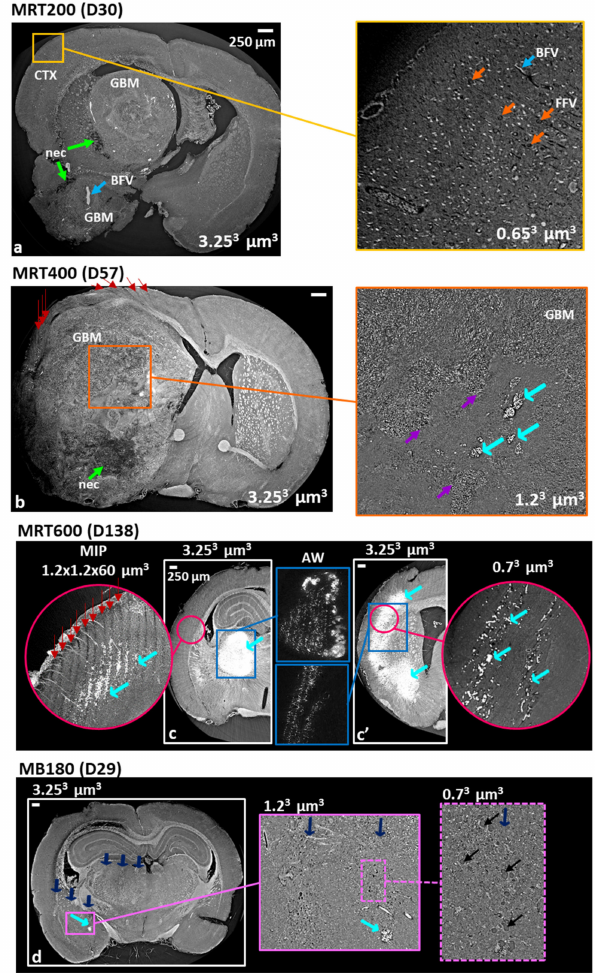
Figure 5. Multi-scale XPCI-CT coronal images of MRT and MB180-treated tumor-bearing brains. The MRT200 sample ( a ) shows great discrimination between healthy and tumor tissue distinguishing necrosis (nec, green arrows) among the GBM structures. A cortex zoom was realized with a 0.7 3 µ m 3 voxel size setup revealing uniform cell content and no MRT path track. Orange and light-blue arrows indicate formalin (ffv) and blood-filled (bfv) vessel. ( b ) Reports an MRT400-treated sample displaying MRT paths induced tissue ablation (red arrows) and necrosis. Its 1.2 3 µ m 3 voxel size inset depicts in detail a hypocellular area where calcium deposits are present (cyan arrows). Purple arrows point at the hypocellular area borders. The panels ( c ) and ( c’ ) present two different coronal views of the same MRT600-treated brain together with their adjust-windowing insets and high-resolution insets showing in detail that microcalcifications developed along the MRT tracks. The maximum intensity projection (MIP) reveals small deposits that are not visible with 3.25 3 µ m 3 voxel size. ( d ) Displays in detail the MB180 induced scars together with cells swelling (yellow arrows) and Ca/Fe deposits (cyan arrows) along the minibeam